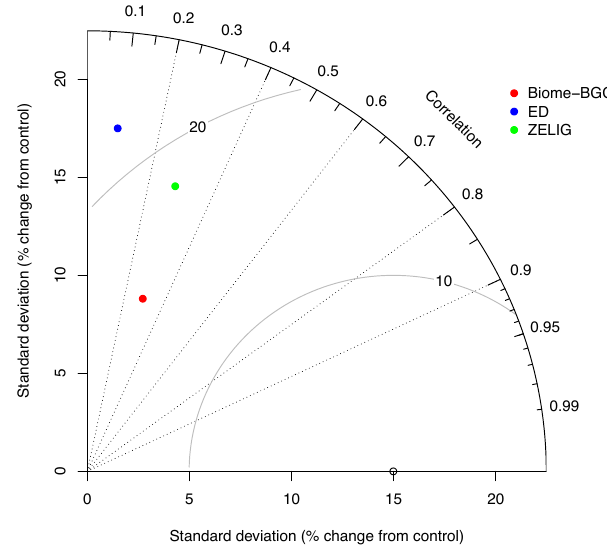
Figure 3. Taylor diagram (Taylor, 2001) summarizing model skill at predicting all (AGB, ER, GPP, LAI, NEP, NPP; cf. Fig. 1) ob- served data, normalized relative to the control forest. The standard deviation of the simulated data (colored by model) is gauged by the radial distance from the origin and can be compared to the observed data (circle on horizontal axis); model correlation to observations is found by azimuthal position; the curve contours show root mean square error (%).